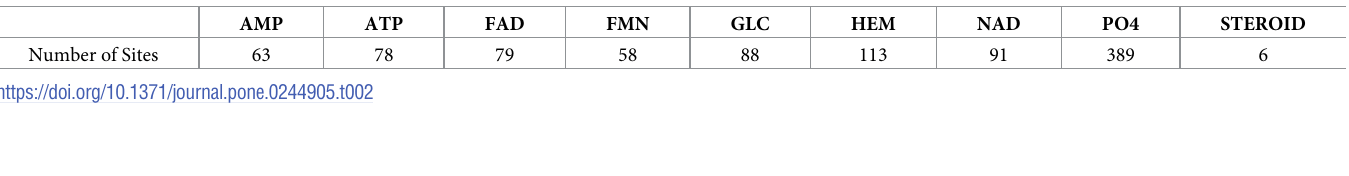
Table 2. Extended Kahraman